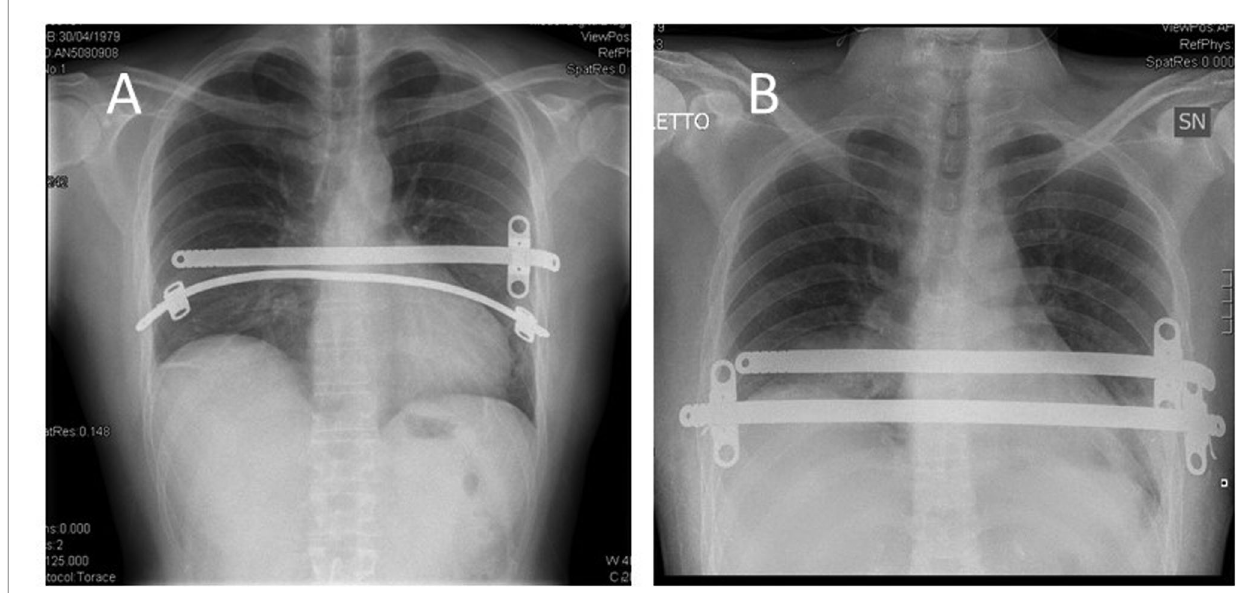
FIGURE 1 | Patient with a dislocation of a bar ( A ) and with the bar in the correct position after surgical revision ( B